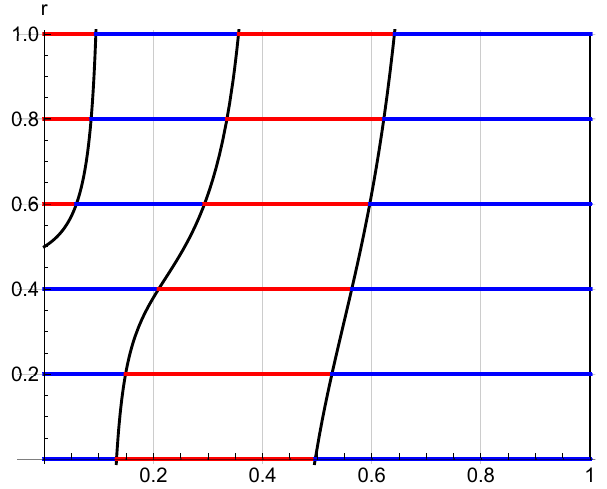
Figure 17. Potential distribution when there is a coupling between the third and fourth modes.